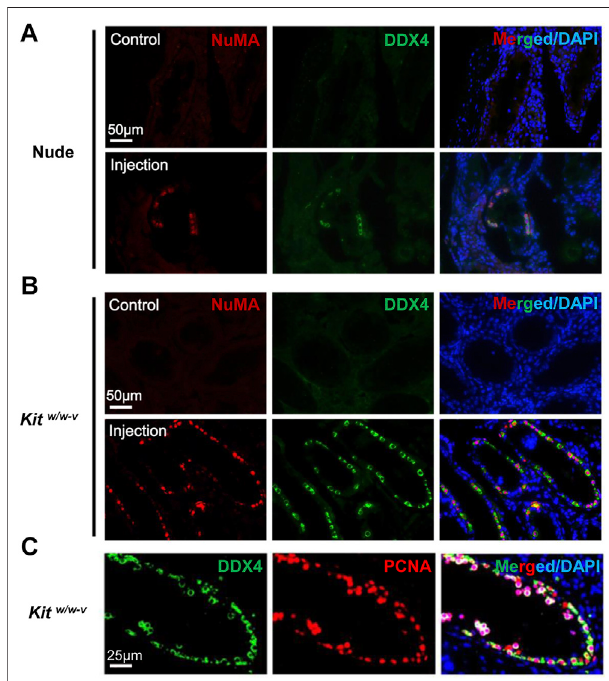
FIGURE 5 | Human SLCs from PSCs readily colonize both nude and Kit w/w-v mouse testes. (A,B) IHF assays were performed 6 weeks post- transplantation on testes from nude mice and Kit w/w-v recipients with antibodies against NuMA and DDX4, counterstained with DAPI. (C) IHF assays on testes from Kit w/w-v mice with antibodies against PCNA and DDX4, counterstained with DAPI. Nude mice at age 6 weeks were injected intraperitoneally with 40 mg/kg busulfan and were subsequently used as recipients after 6 weeks. Male Kit w/w-v mice at 12-week old were used as recipients.About~100,000EpCAM-/TNAP+SLCswereinjectedpertestisfor xenotransplantation. The contralateral testis in the same mouse with mock PBS injection was used as a control. In total, 4 nude mice and 6 Kit w/w-v mice were injected.